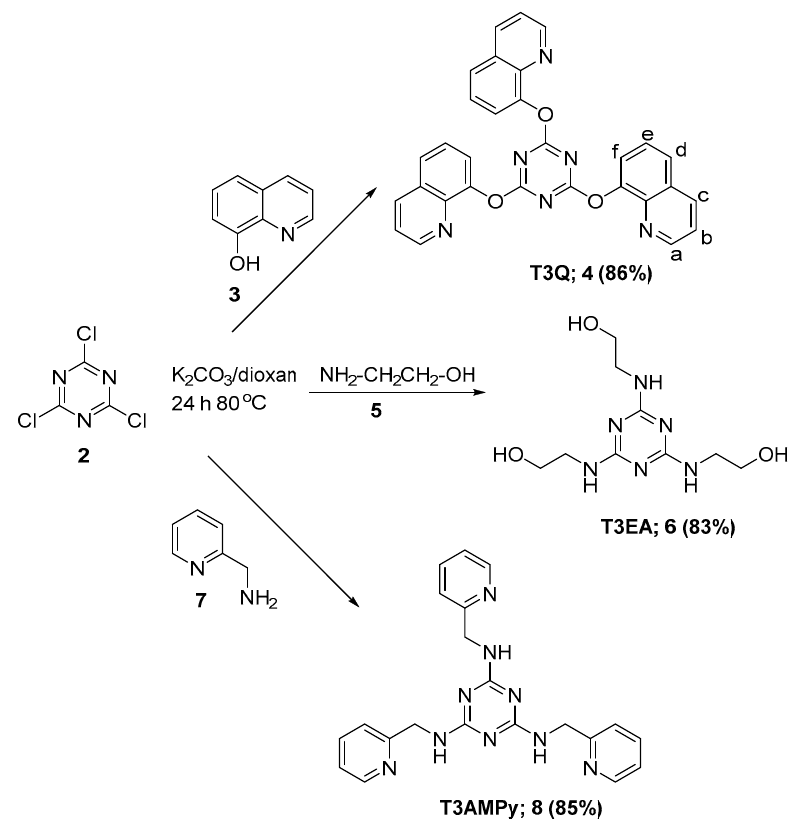
Scheme 1. Synthesis of the organic inhibitors 4 , 6 , and 8 .